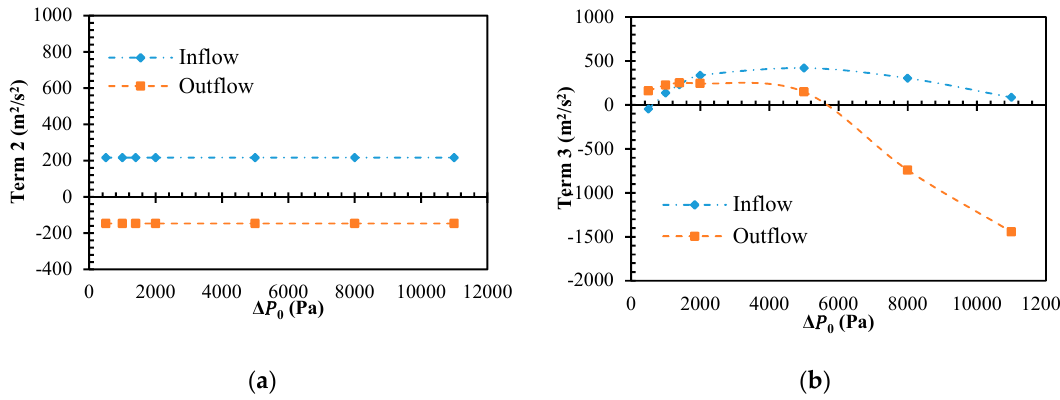
Figure 22. Comparison of the energy transfer terms of the outflow and inflow turbines. ( a ): Term 2 (change in blade speed); ( b ): Term 3 (change in relative velocity).